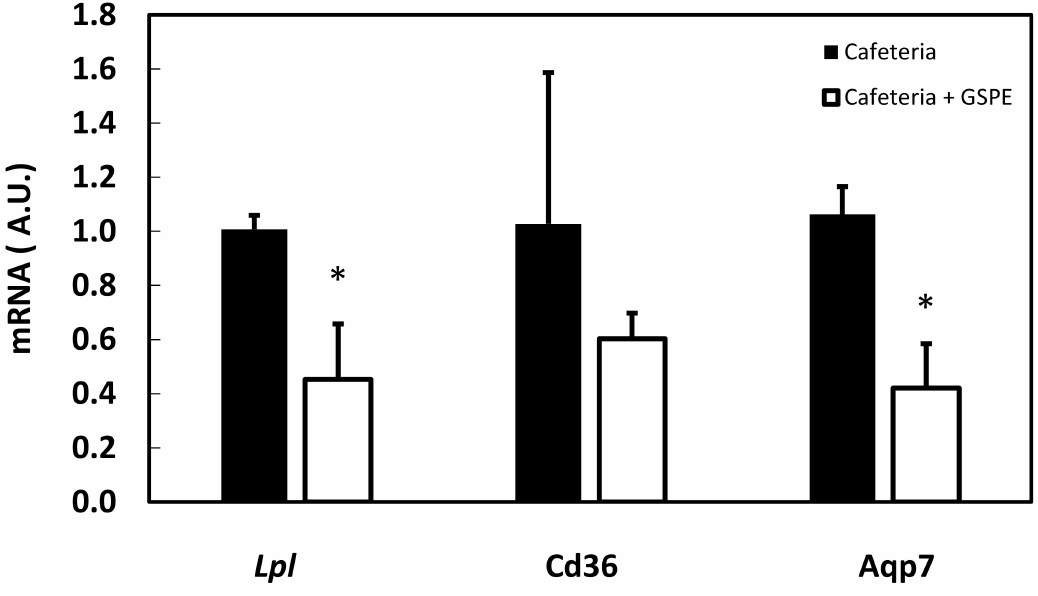
Figure 3. E ff ect of GSPE pre-treatment on mesenteric adipose gene expression in the short-cafeteria study at the end of the study. Rats were treated with 0.5 g / Kg BW for the first 10 days, and then they were put on a chow diet for 18 days and a cafeteria diet for 35 days. The black column indicates animals not treated with GSPE. The white column indicates animals treated with 0.5 g / Kg BW of GSPE for the first 10 days of treatment. The mRNA extracted from mesenteric adipose was quantified by RT-PCR and the relative gene expression of Lpl , Cd36 and AqpP7 was obtained by the DDCt method in each gene. The data are the mean ± S.E.M. (n = 7). Statistical di ff erences identified by t -test are defined by * when p < 0.05 between